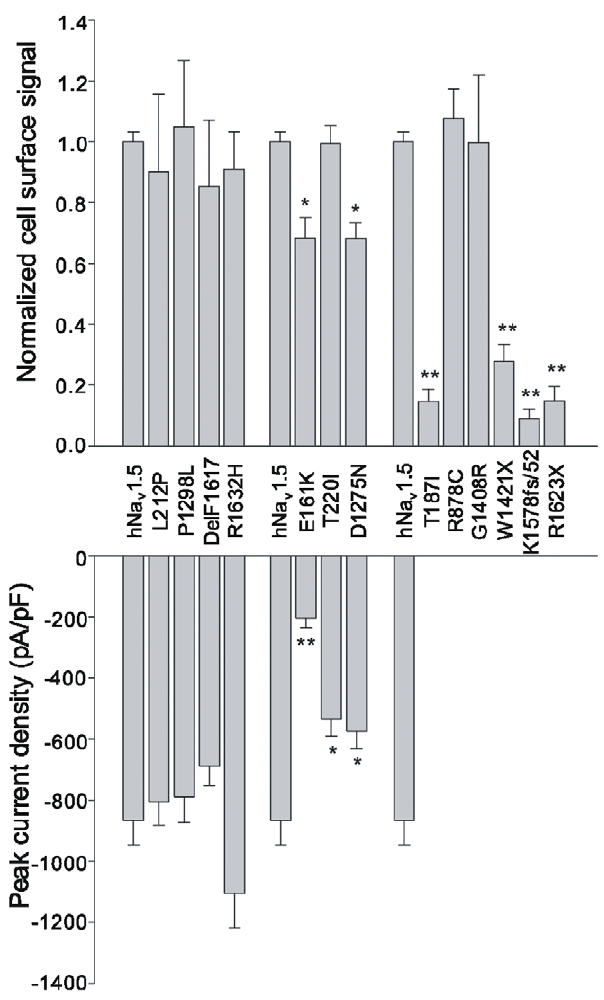
Figure 6. Correlation between cell surface expression and peak current densities for the thirteen SSS-associated mutant channels. Normalized cell surface signals were obtained by dividing the ‘‘cell surface’’ signal by the corresponding ‘‘total’’ signal; both signals being obtained from the same Western blot (see Fig. 5). A ratio obtained for a mutant was further normalized by dividing with the ratio obtained for wild-type hNa v 1.5 again from the same blot. The mean double-normalized cell surface signals shown were calculated from at least three independent biotinylation experiments. * indicates p , 0.05, ** indicates p ,